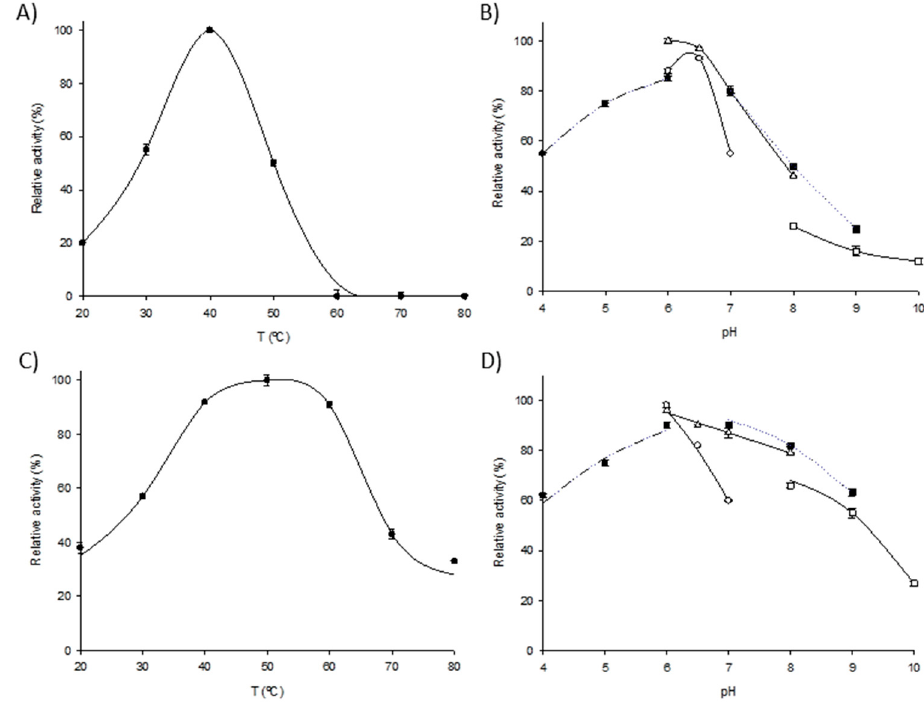
Figure 2. Biochemical characterization of M Lm PDT3 and M Ec HPRT3. ( A ) Effect of temperature on M Lm PDT3 activity ( ● ). ( B ) Effect of pH on M Lm PDT3 activity, ( ● ) 50 mM sodium citrate (pH 4–6), ( (cid:52) ) 50 mM sodium phosphate (pH 6–8), (